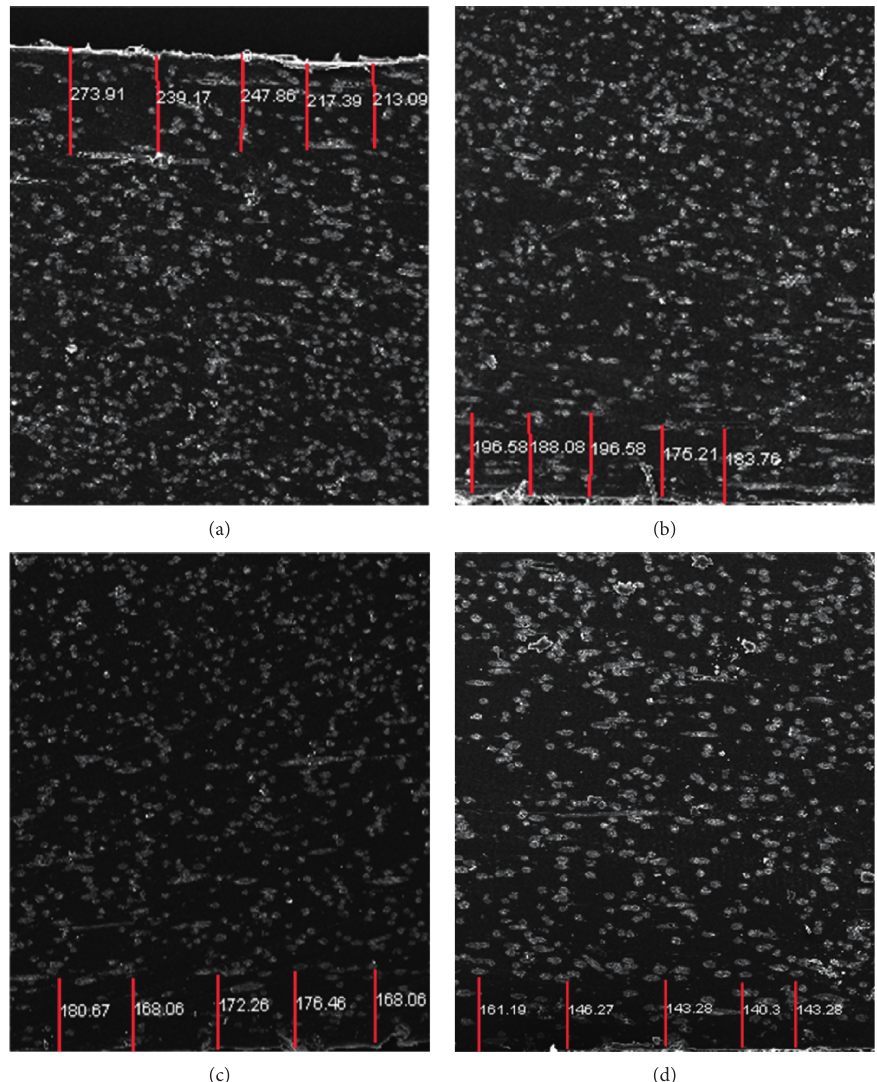
Figure 4: SEM micrographs of skin layer thickness in RHCM and CIM samples produced at different cavity surface temperatures before filling: (a) CIM; (b) RHCM60; (c) RHCM90; (d) RHCM120 (unit: μ m).